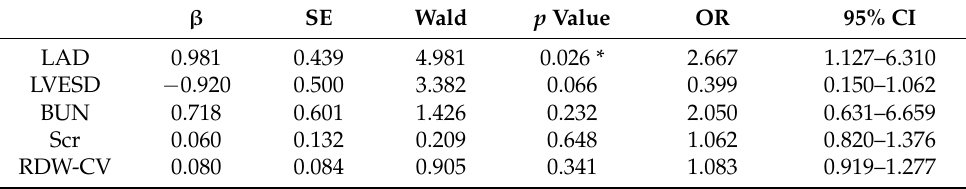
Table 4. Multivariate logistic regression analysis on predictors of persistent AF.